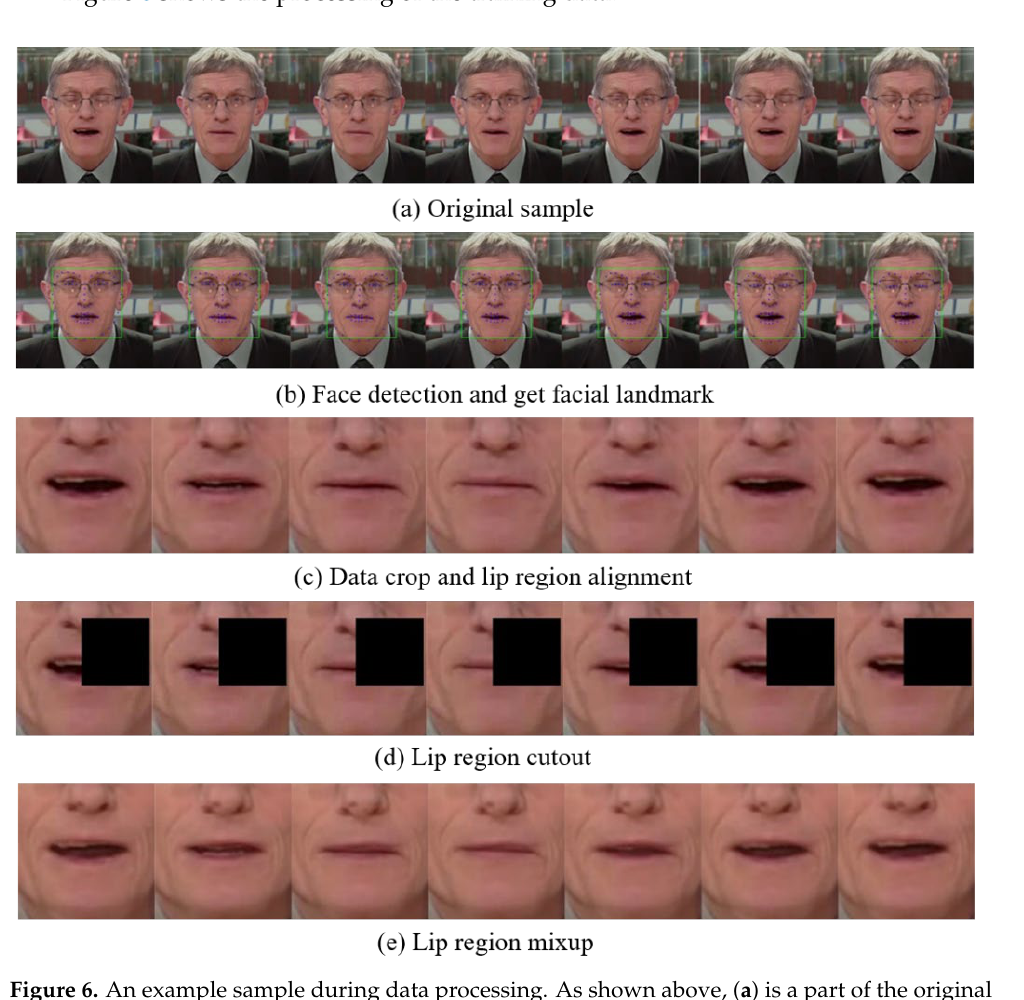
Figure 6. An example sample during data processing. As shown above, ( a ) is a part of the original data in the Lipreading in the Wild (LRW) dataset. ( b ) is the result of using the Dlib toolkit to get facial landmarks while the green rectangle is the region of the face, and the blue point is the facial landmarks. ( c ) is the process result of data crop and lip alignment. ( d , e ) is the result of mix-up and cutout during training.